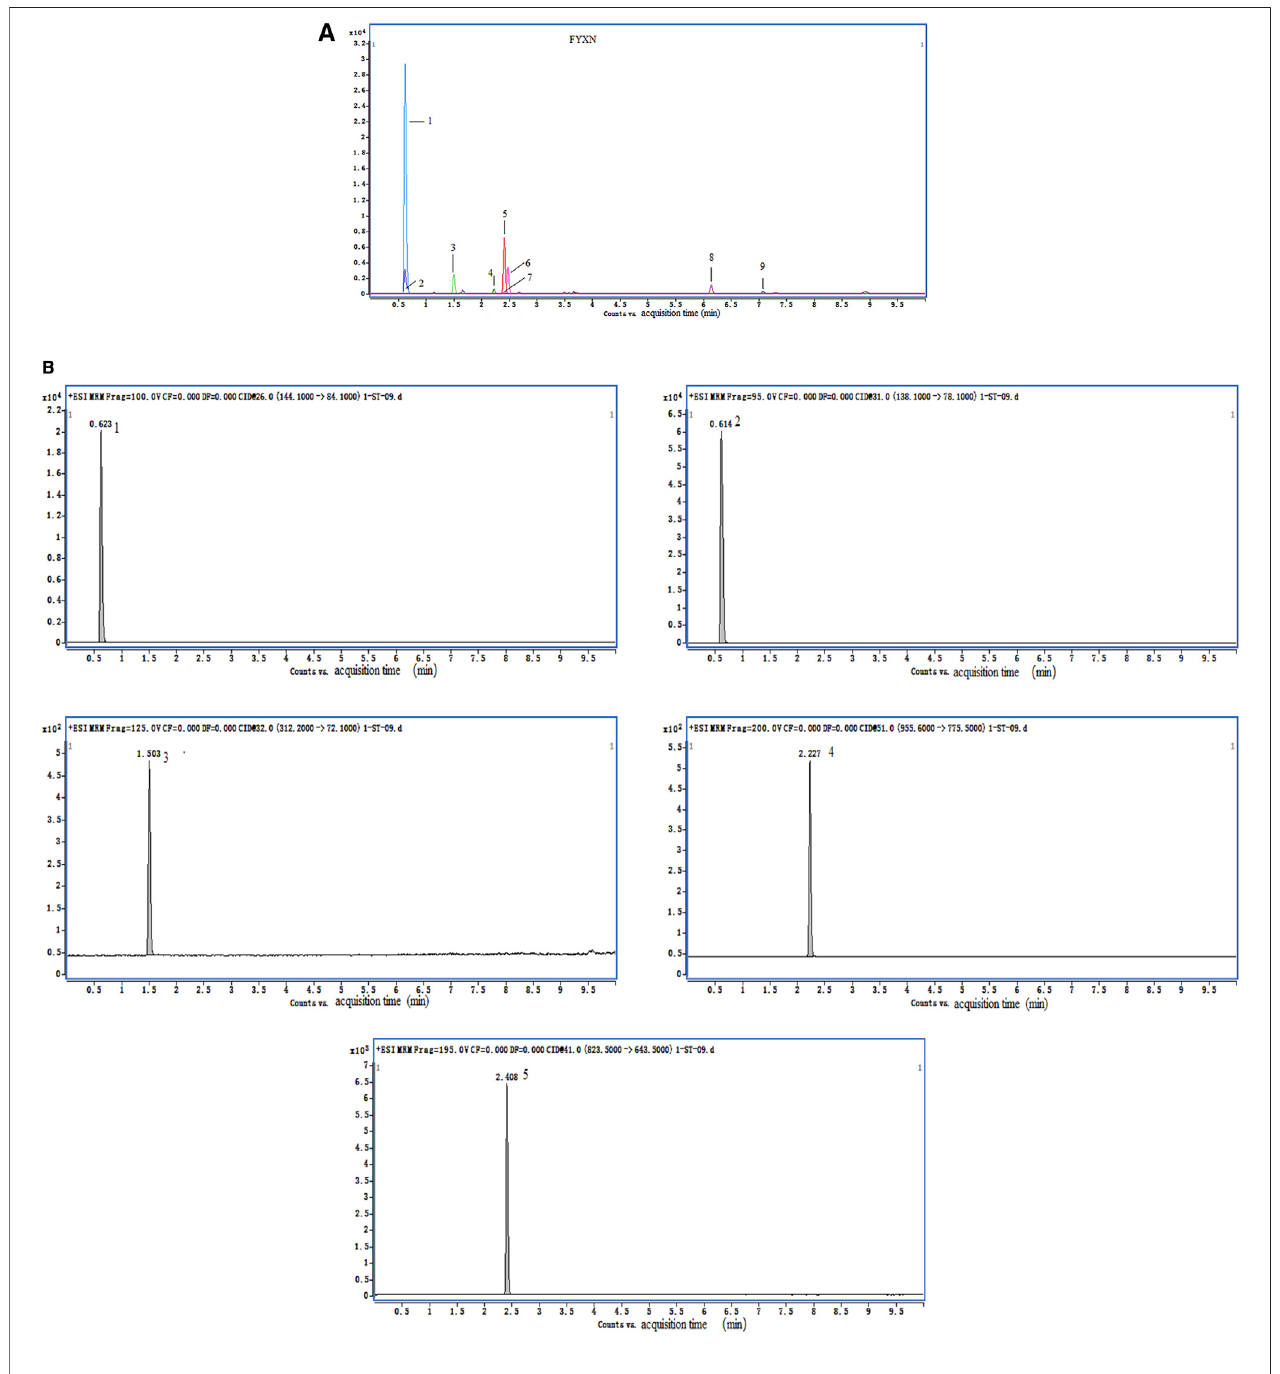
FIGURE 1 | HPLC data of FYXN. (A) and (B) show total ion chromatograms and standard sample. The peaks indicate the presence of stachydrine hydrochloride (1), trigonelline (2), leonurine hydrochloride (3), notoginsenoside R1 (4) and ginsenoside Rg1 (5), which con fi rms the authenticity and major pharmacologically active constituents of